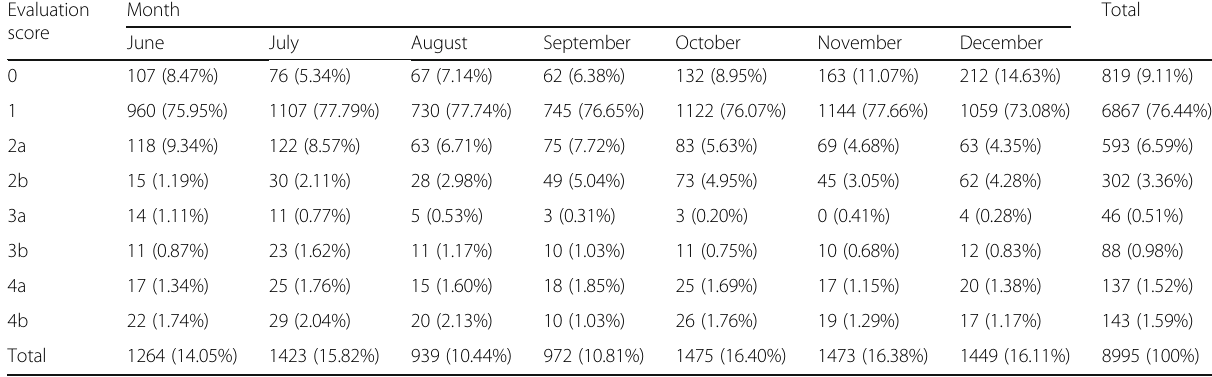
Table 5 Distribution by evaluation score over time Evaluation